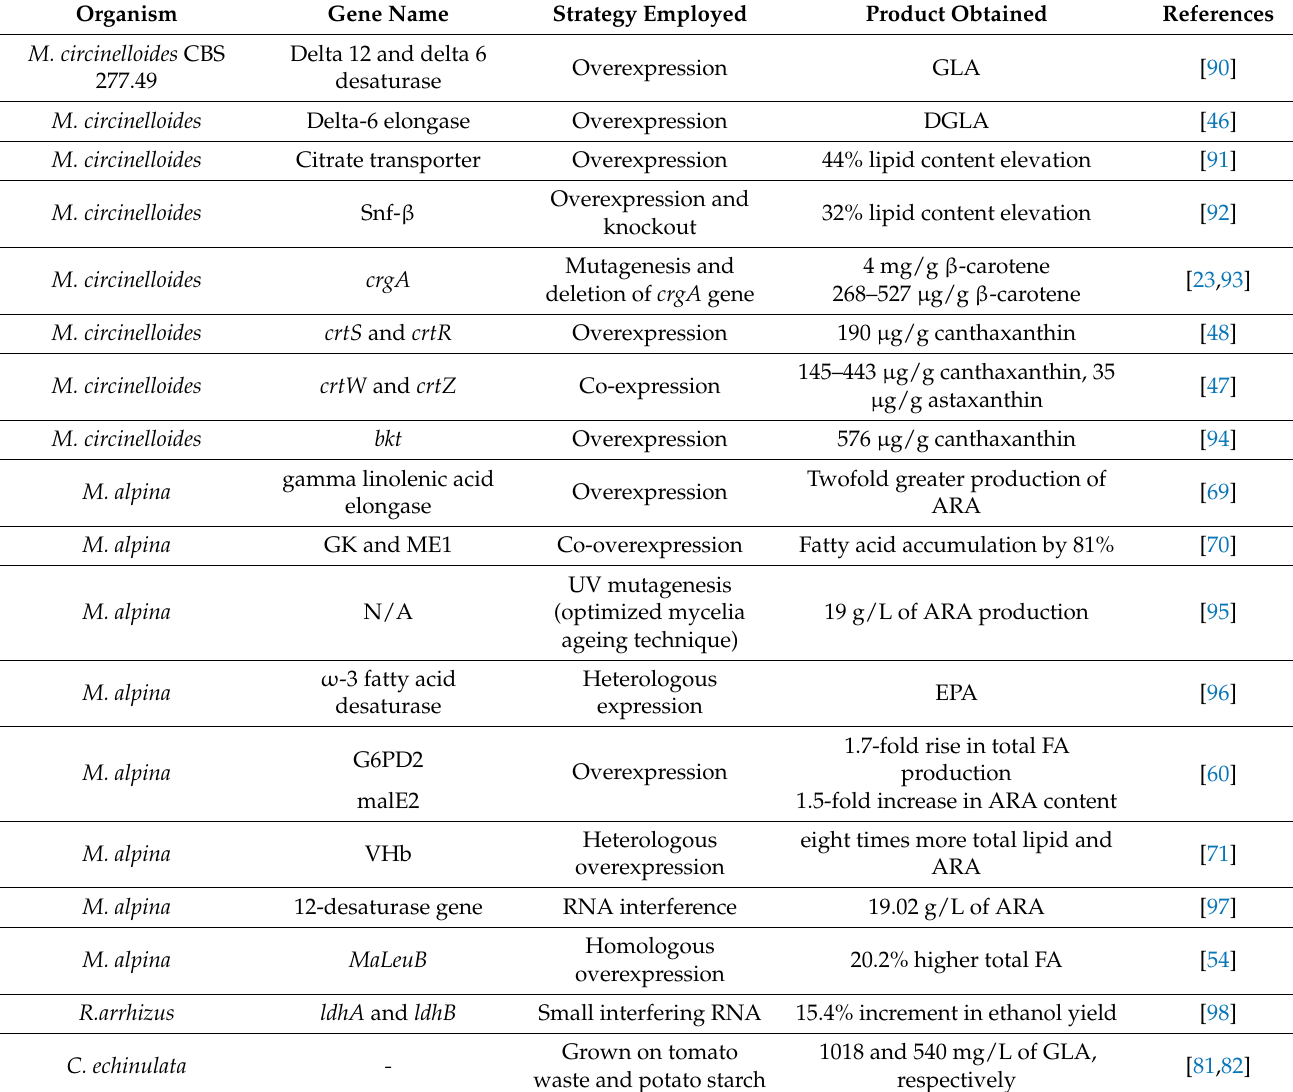
Table 1. Representative microorganisms of some selected Mucoromycota and employed engineering strategies for their production of valuable bioactive